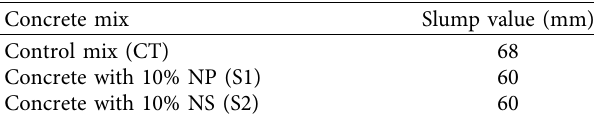
Table 5: Concrete workability.